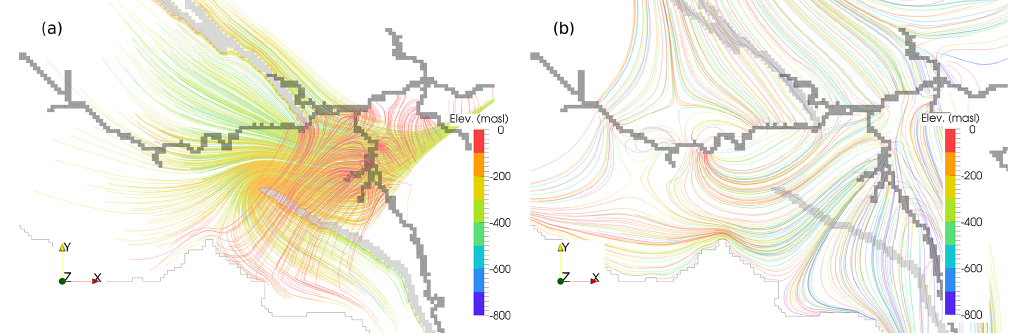
Figure 13. Detail of flow paths near faults and bottleneck structure; pathlines colored by elevation; area shown in Fig. 12: (a) heterogeneous simulation S1, (b) homogeneous simulation